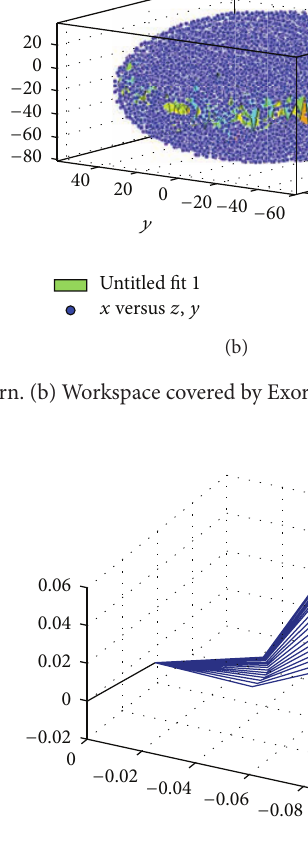
Figure 28: Motion due to shoulder griddle.